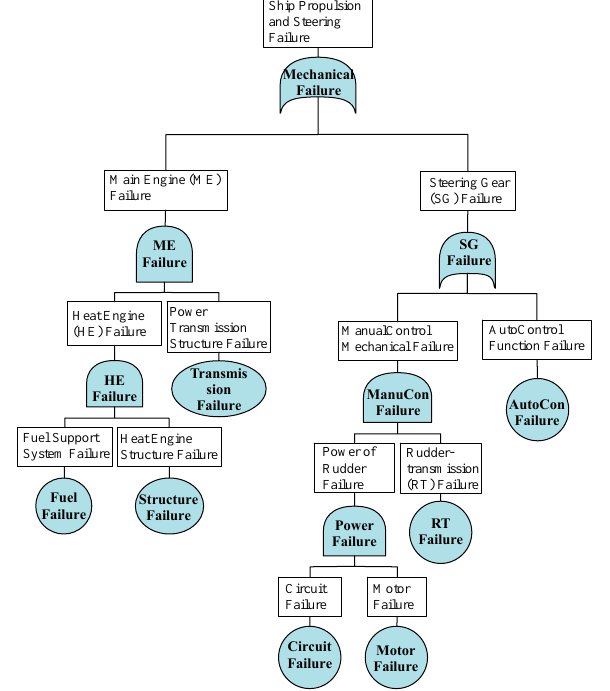
Figure 8. the FT model of Ship Propulsion and Steering Failure (linked with PE 7/9/12).